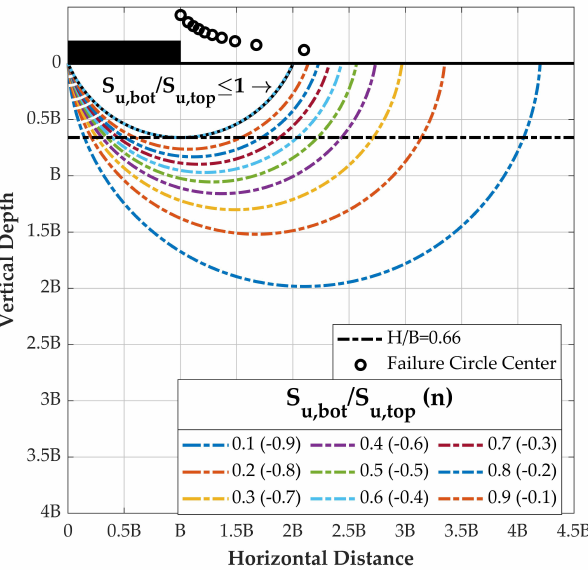
Figure 14. Slip surfaces shrink with the increasing n for S u , bot / S u , top <